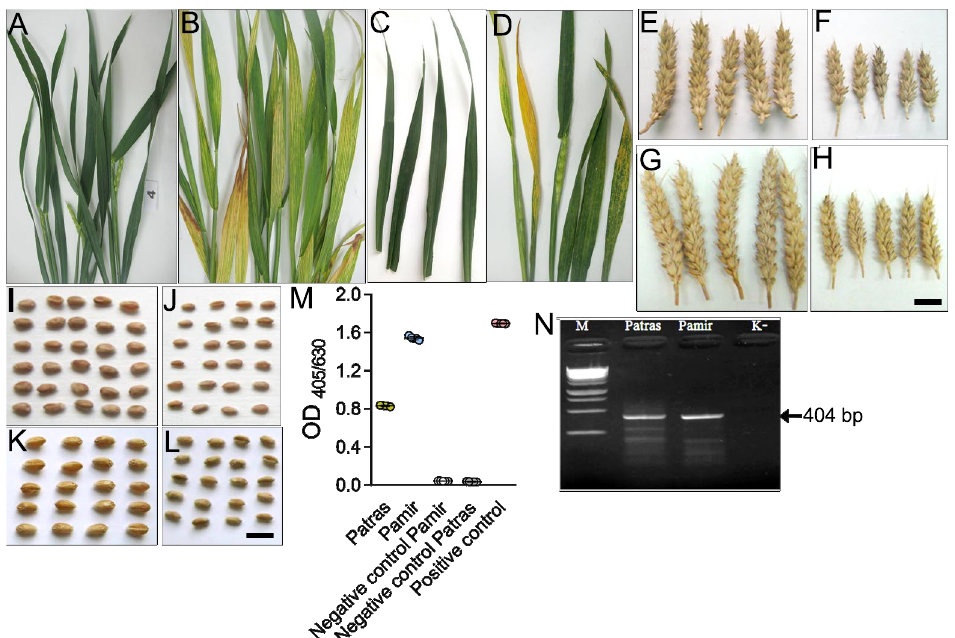
Figure 1. Diagnostics of WSMV infection in winter wheat leaves. ( A , B ) Representative images of healthy ( A ) and diseased ( B ) plants of variety Pamir. ( C , D ), Representative images of healthy ( C ) and diseased ( D ) plants of variety Patras. ( E – H ) Representative images of spikes collected from control ( E , G ) or infected ( F , H ) Pamir ( E , F ) or Patras ( G , H ) plants. Scale bar, 2 cm. ( I – L ), Representative images of spikes collected from control ( I , K ) or infected ( J , L ) Pamir ( I , J ) or Patras ( K , L ) plants. Scale bar, 1 cm. ( M ), Detection of WSMV in the infected leaves by ELISA. Total virus preparation was used as a positive control and a healthy-looking plants were used as a negative controls. Three technical replicates (individual plants) were performed. The difference between healthy and infected plants was significant ( p < 0.001). ( N ), Detection of WSMV in the infected leaves using PCR. Gel electrophoresis shows 404 bp RT-PCR fragments amplified using RNA from infected leaves using primers for the viral coat protein gene. As a negative control, RNA isolated from a healthy-looking plant was used (lane marked as K). Lane marked as M contains DNA size markers corresponding to the following values: 10000, 8000, 6000, 5000, 4000, 3500, 3000, 2500, 2000, 1500, 1000, 750, 500, 250 bp.